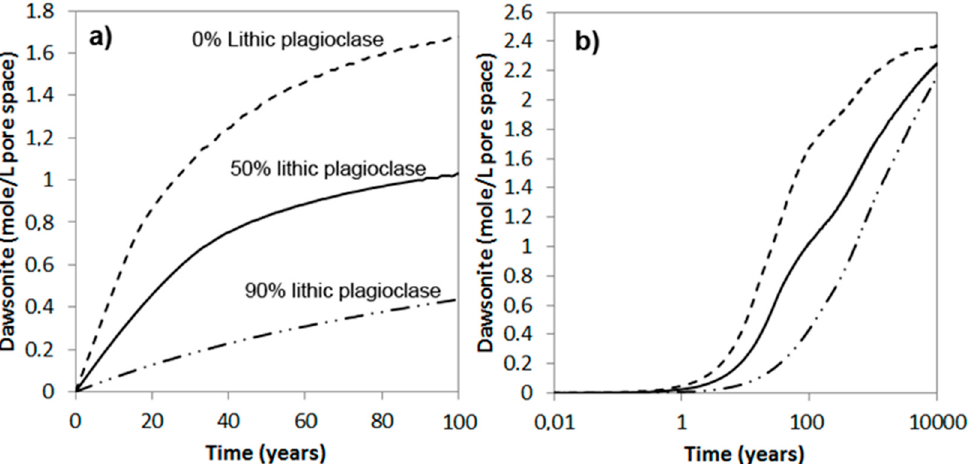
Figure 8. Simulated feldspar dissolution of equal wt % feldspars for ( a ) very fine grained sand, and ( b ) medium-grained sand. Feldspars were divided into perthitic K- and Na-feldspars, K-feldspar and plagioclase in lithic fragments, and detrital plagioclase grains; ( c ) micrographs from corresponding facies in the Johansen Formation: very fine grained and medium grained sandstones. Pore space is filled with blue epoxy; ( d ) amount of dawsonite that forms from feldspar dissolution for very fine grained and medium grained sand lithologies. The two cases correspond to a) and b) (this figure).